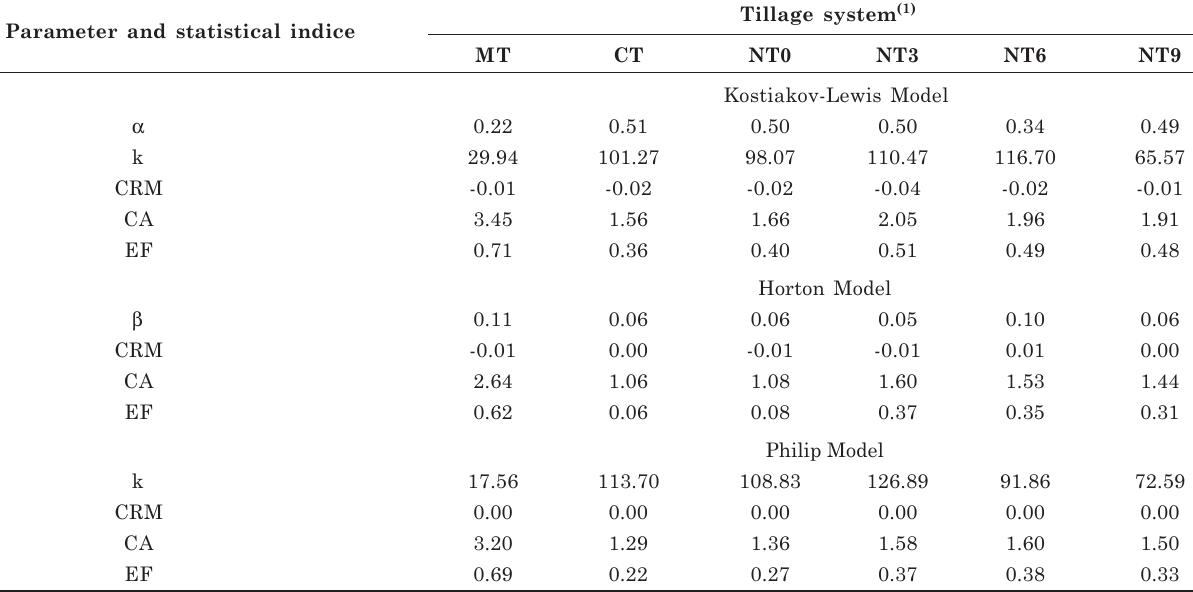
(1) MT: minimum tillage; CT: conventional tillage; NT0: no tillage without plant residue; NT3: no tillage with 3 Mg ha -1 of plant residue; NT6: no tillage with 6 Mg ha -1 of plant residue; NT9: no tillage with 9 Mg ha -1 of plant